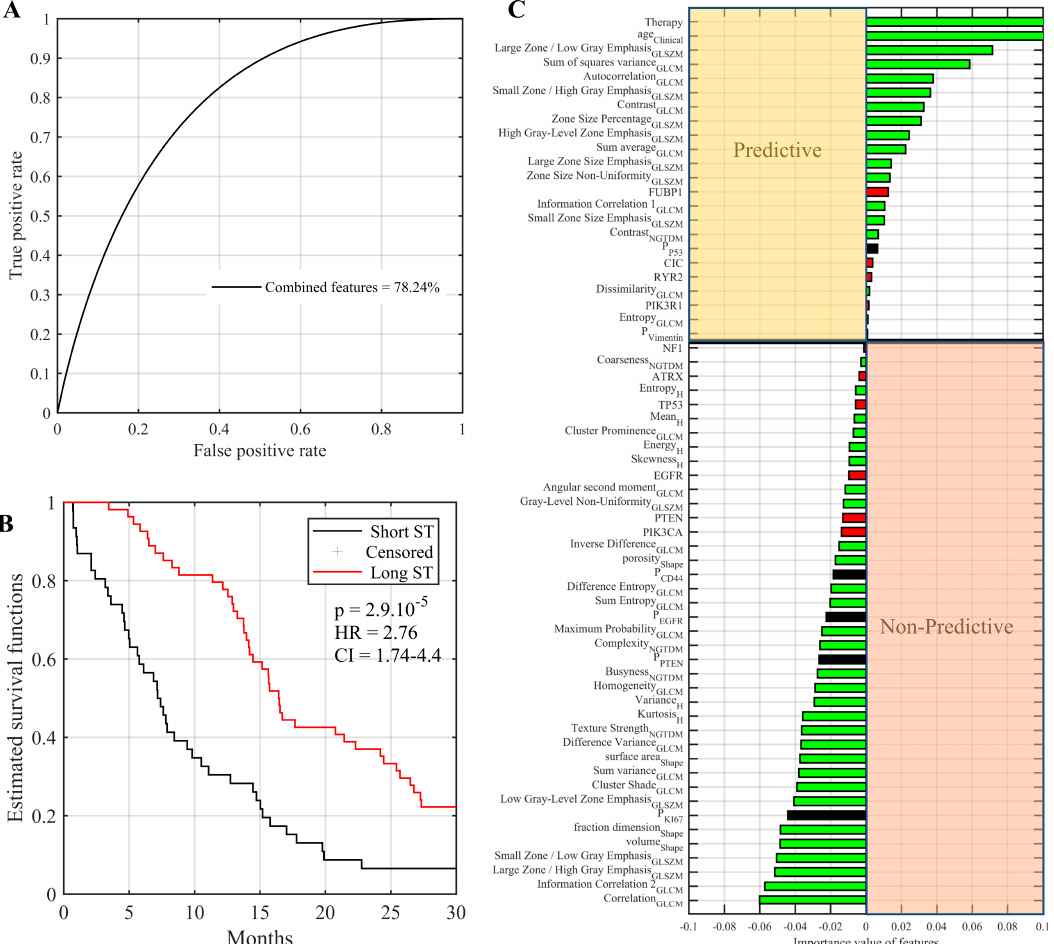
Figure 3. Validation of omics model for predicting the OS groups (i.e., short and long survival outcome) with IDH1 wild type GBM patients using 100 patient datasets for training and 100 for test ( A ) Area under the ROC of combined features derived from radiomics, genomics, IHC, and transcriptomics for predicting OS groups. ( B ) Kaplan–Meier curve of the patients’ groups that predicted their OS by omics model. ( C ) Importance of individual features for predicting OS groups (i.e., short and long survival outcome) using the RF classifier. Reported values correspond to the average increase in prediction error obtained by permuting the values of individual features across out-of-bag observations [25]. Positive and negative values correspond respectively to predictive and non-predictive